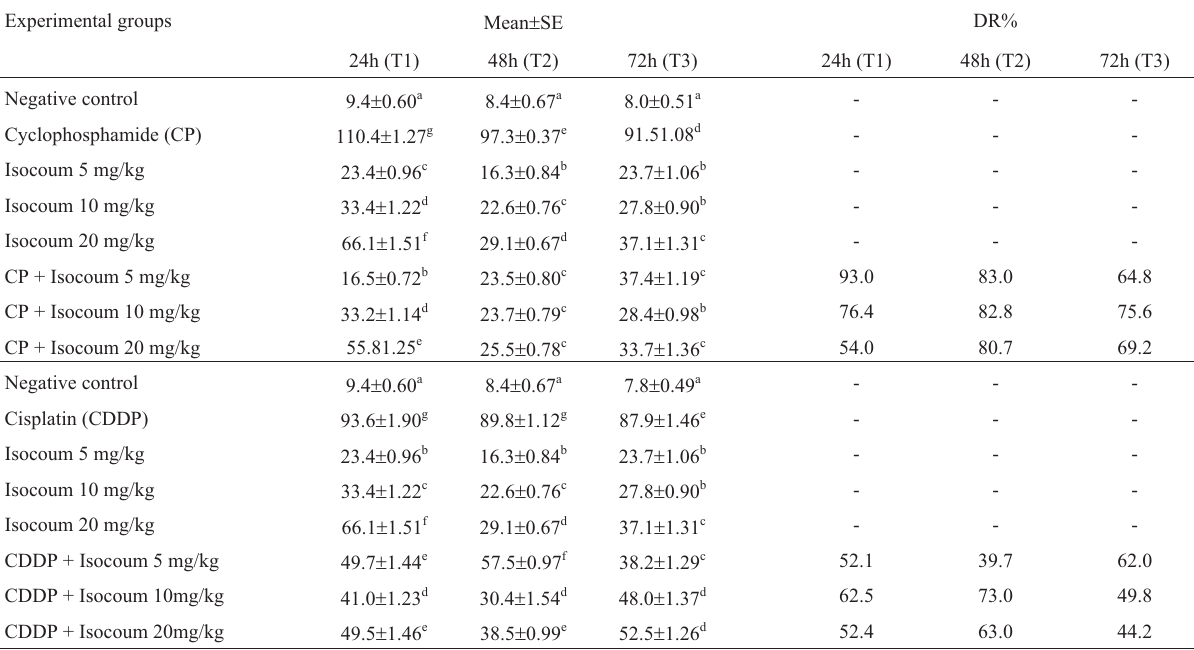
Table 3 - Mean frequencies (cid:5) SE of the damage reduction percentage as determined by the micronucleus assay in mouse peripheral blood cells. Experimental